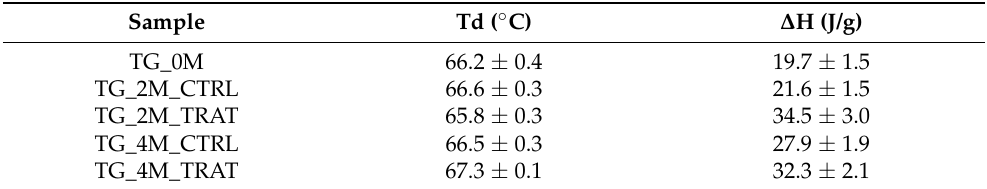
Table 2. Mean values of the endothermic peak (Td) and enthalpy ( ∆ H) required for the endothermal transition that occurred on skin samples ( n = 9, mean ± SD).